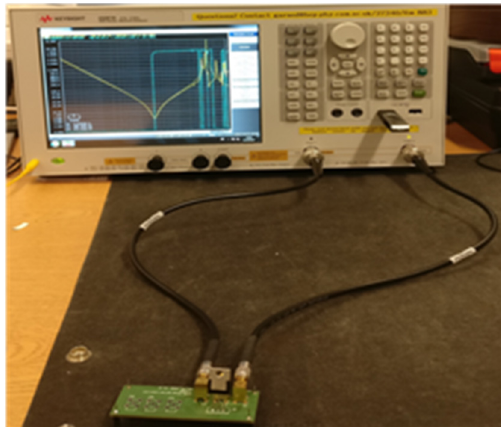
Figure 10. Measurement set-up for GaN device impedance extraction using VNA.